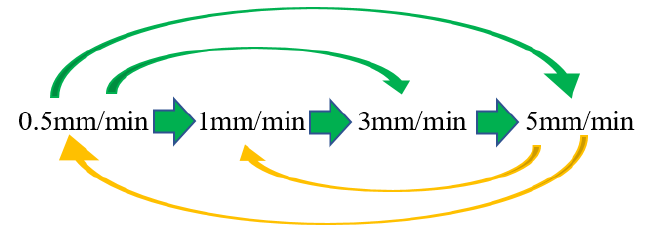
Figure 2. Loading rate change diagram.